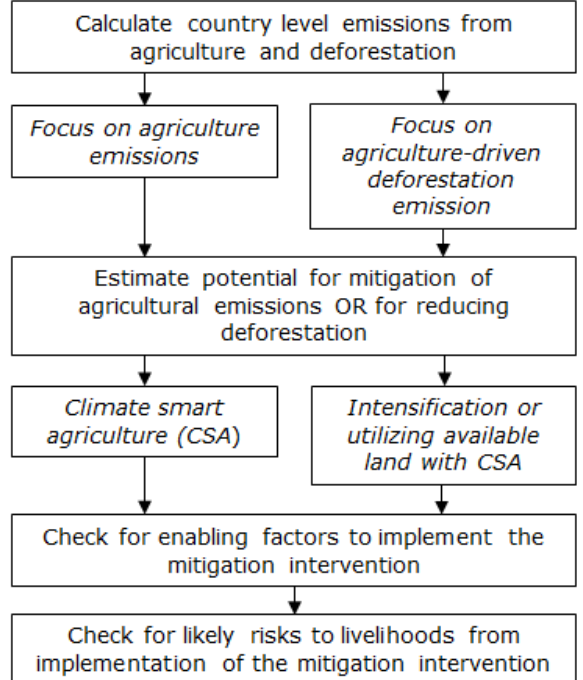
Figure 1. National-scale assessment of the need, potential and risk of implementing interventions to reduce emissions from agriculture and agricultural-driven